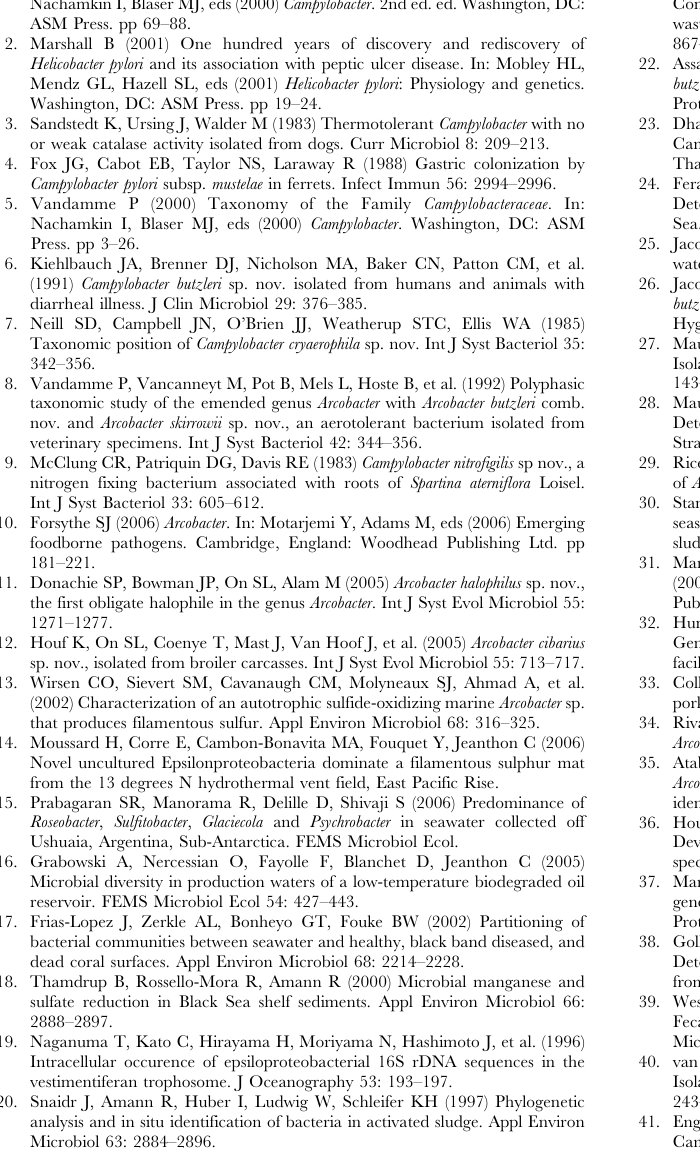
Table S6 CDS contained in all A. butzleri strains examined. Core set of 1676 genes identified in RM4018 and all 12 additional A. butzleri strains by comparative genomic indexing. The functional annotation of each gene is provided.